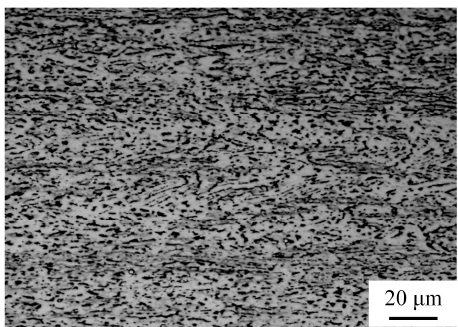
Figure 2. Optical micrograph of as-rolled Ti-Al-4V alloy prior to superplastic tensile deformation.